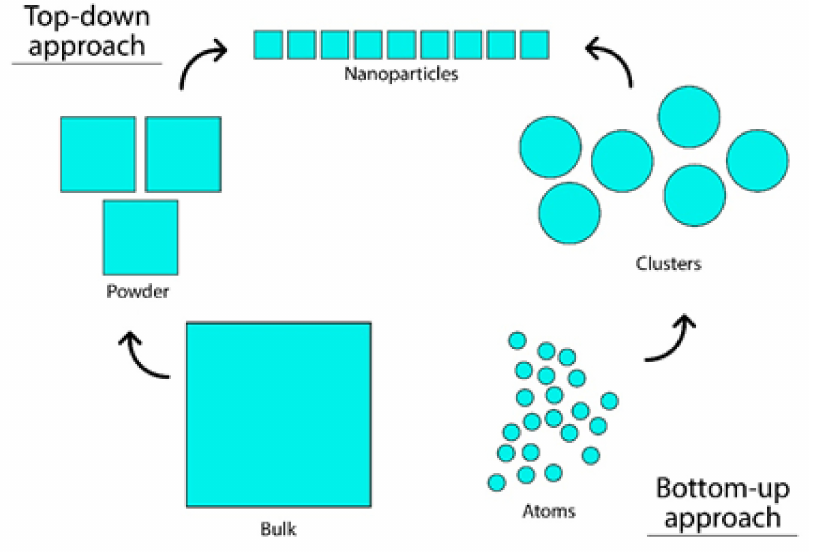
Figure 1. The approaches in silver nanoparticle synthesis involve bottom-up and top-down